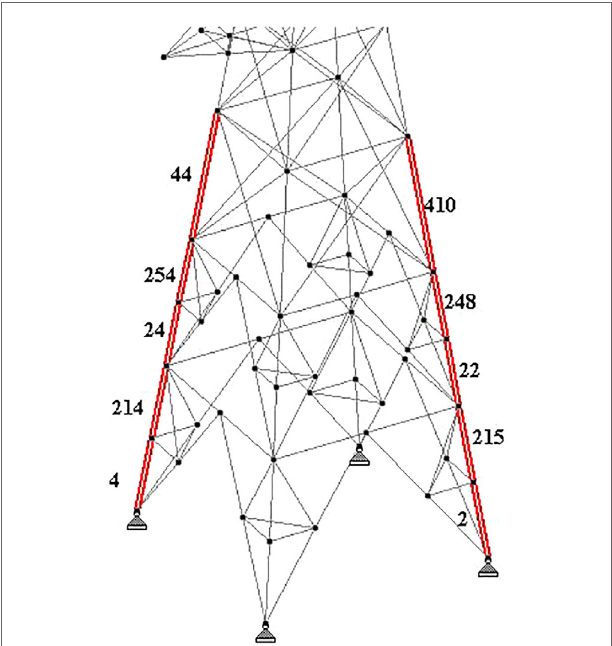
FigUre 6 | intuitive method of placing sensors by maximum forces .